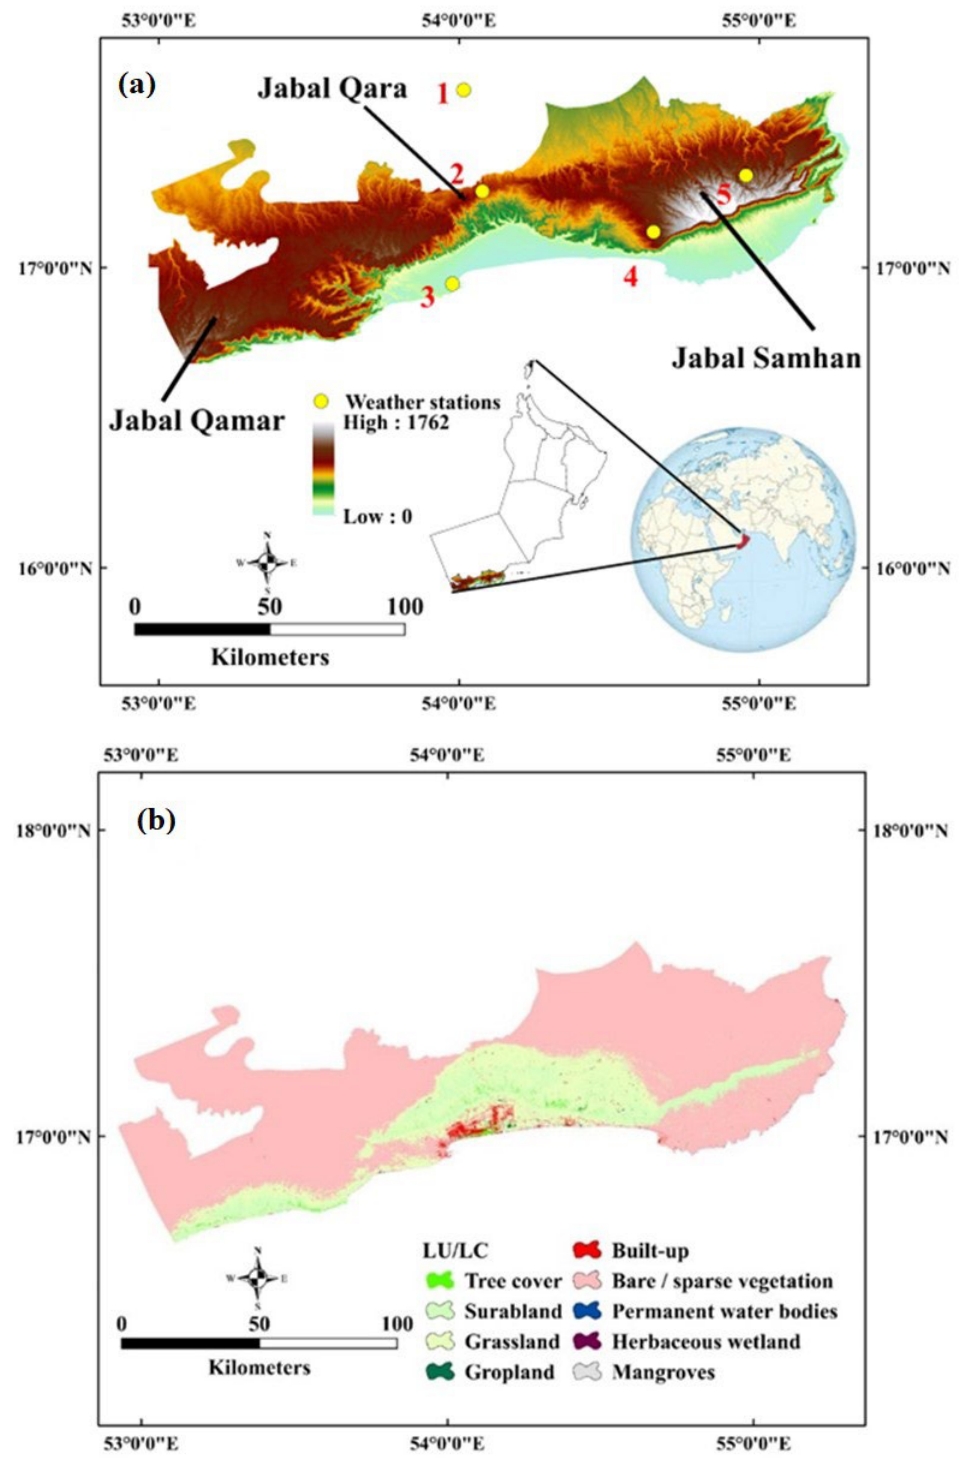
Figure 1. The study area: ( a ) the Dhofar elevation map with weather station locations and the Dhofar portion of the Salalah plain and mountain ranges (Jabal Qara, Jabal Qamar, and Jabal Samhan). ( b ) Data from Sentinel-2 indicate the land use and land cover zones in the study area.